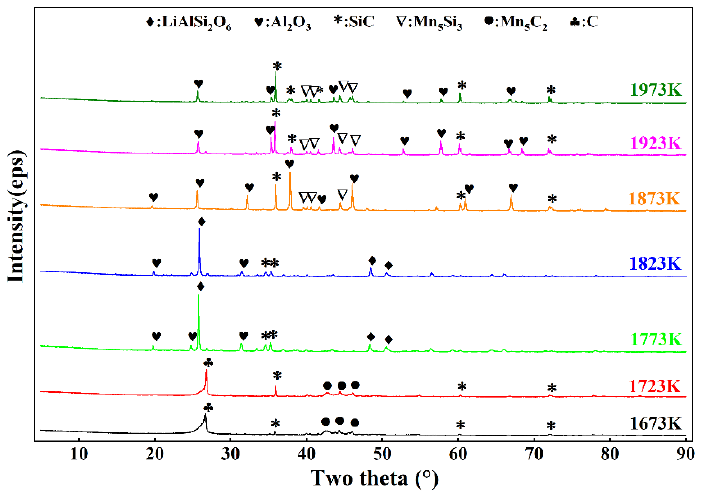
Figure 6. XRD patterns of the upper layer at varying reduction temperatures.